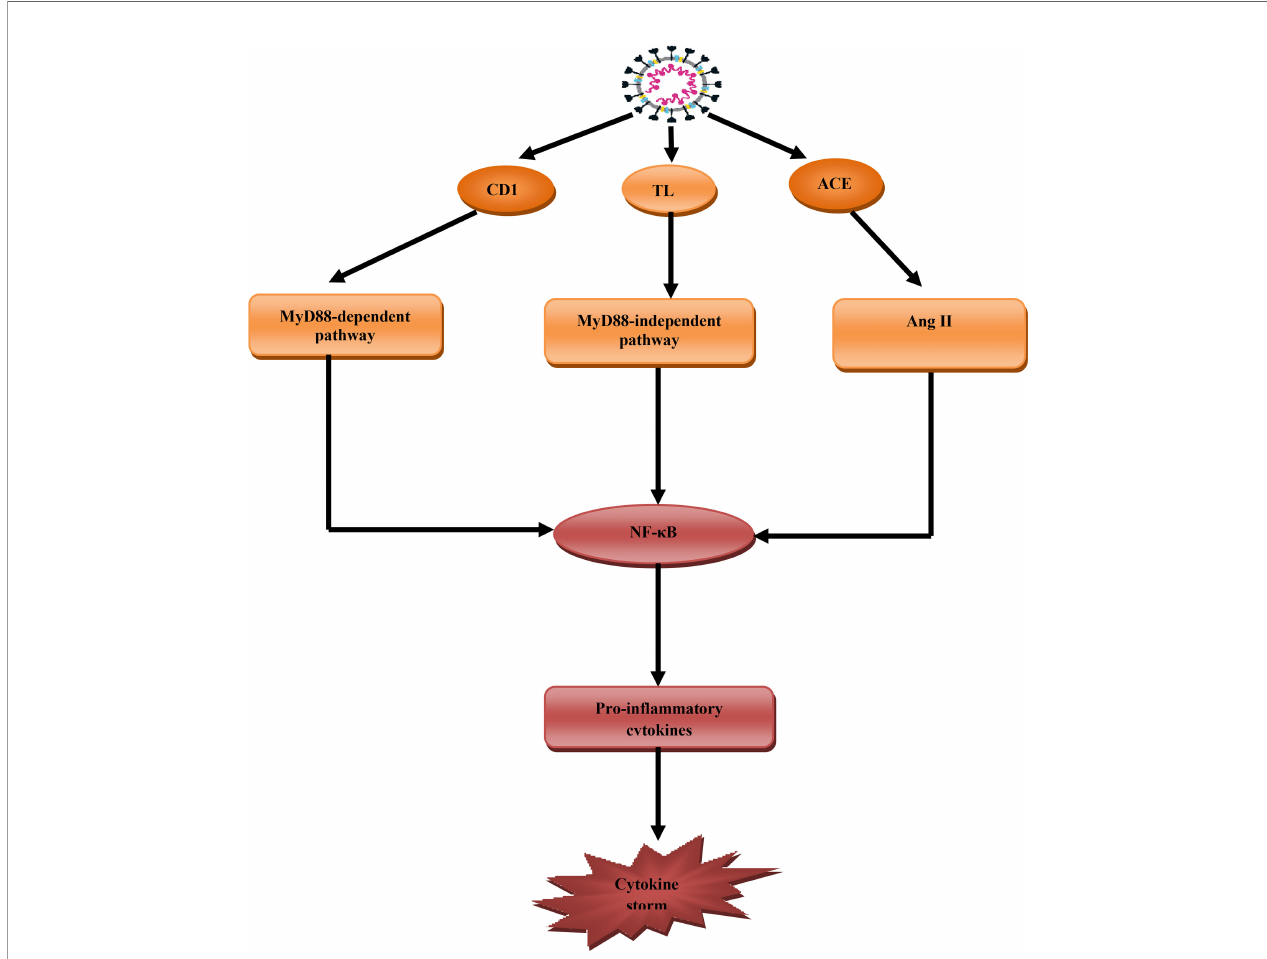
FIGURE 5 | Role of SARS-CoV-2 in the development of cytokine storm (CS): SARS-CoV-2 through activation of CD147 activate myeloid differentiation 88 (MyD88), through toll-like receptor 4 (TLR4) and ACE2 activate angiotensin II (AngII) that together trigger NF- k B pathway, which stimulates the release of pro-in fl ammatory pathway and development of cytokine